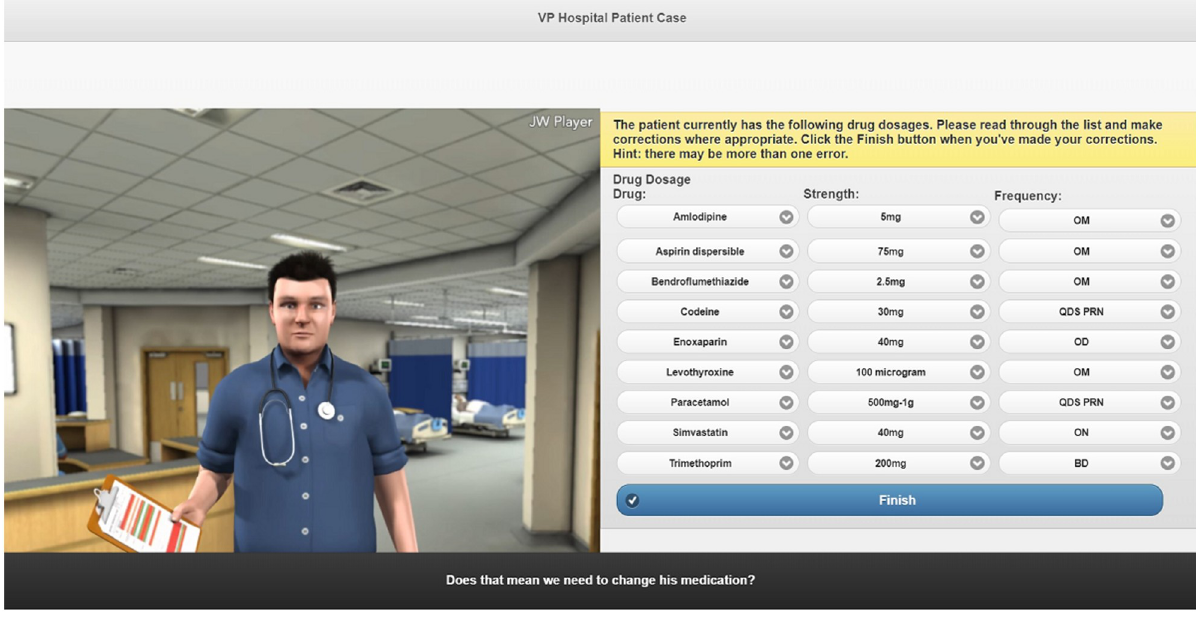
Fig 2. Screenshot of the renal function VP